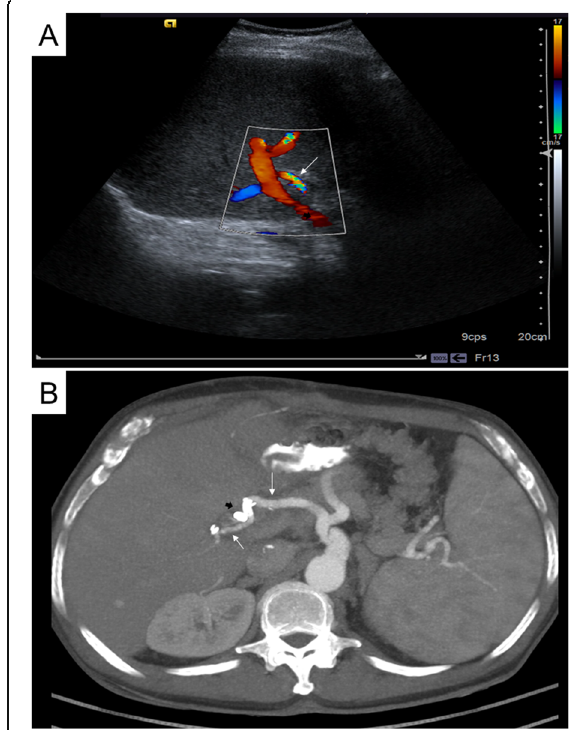
Fig. 3 Contrast-enhanced CT and doppler ultrasound post-treatment follow-up. a Doppler ultrasound performed just before the patient ’ s discharge demonstrates the stent ’ s correct permeability within the hepatic artery (thin white arrow). b Axial section processed with a MIP of a contrast-enhanced CT in arterial phase performed 18 months after the procedure, showing the correct placement of the covered stent (thick black arrow) and hepatic artery patency (thin white